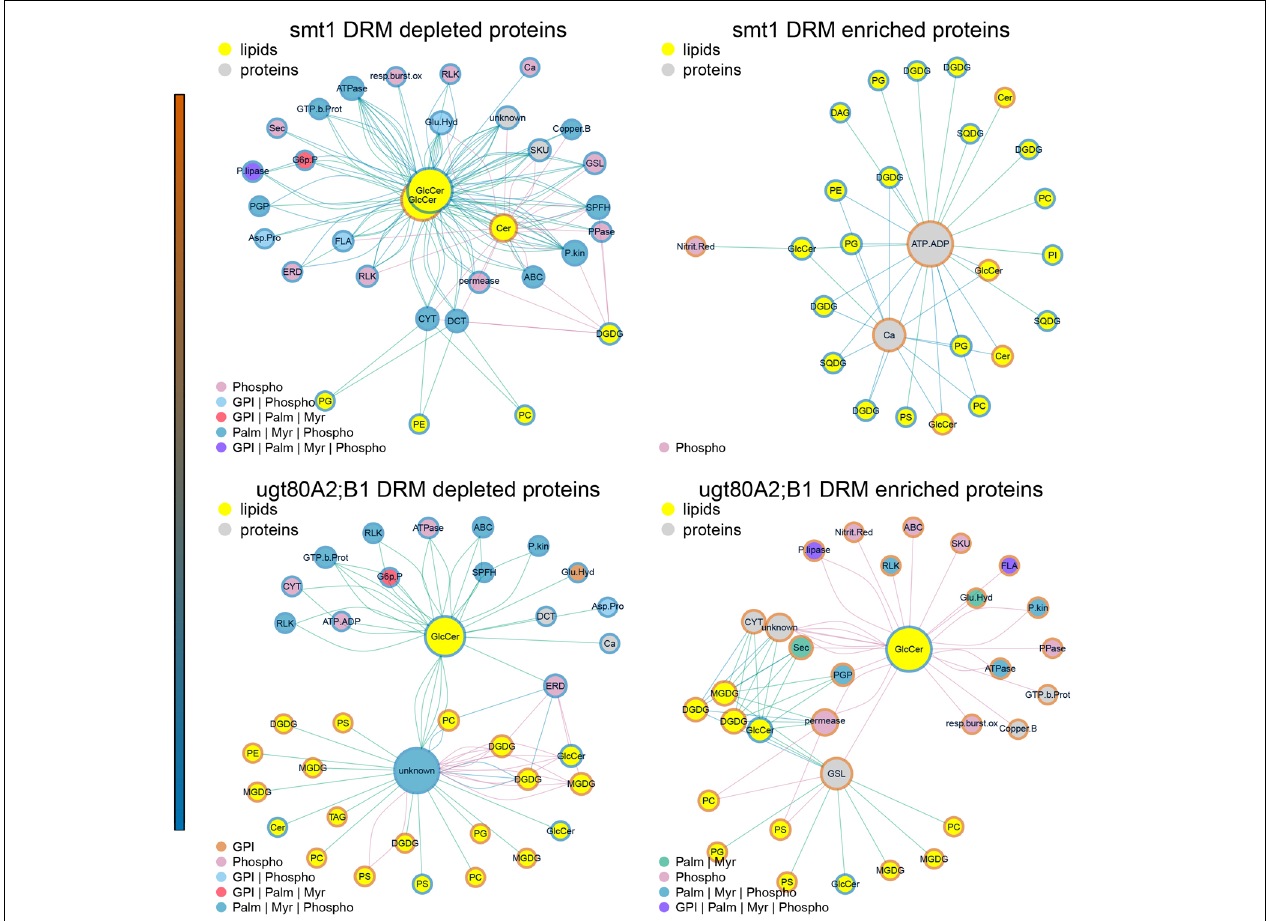
FIGURE 5 | Subnetworks of lipid–protein interactions (Figure 4) filtered for edges between commonly identified protein groups of ugt80A2;B1 and smt1 . Networks were further separated into proteins exhibiting an increased (red) or decreased (blue) DRM/DSF ratio. Abbreviations of protein groups are explained in Table 1 and Lipid species in Figure 4 . Proteins could be divided into ceramide-dependent or non-dependent classes which show a high degree in edges with